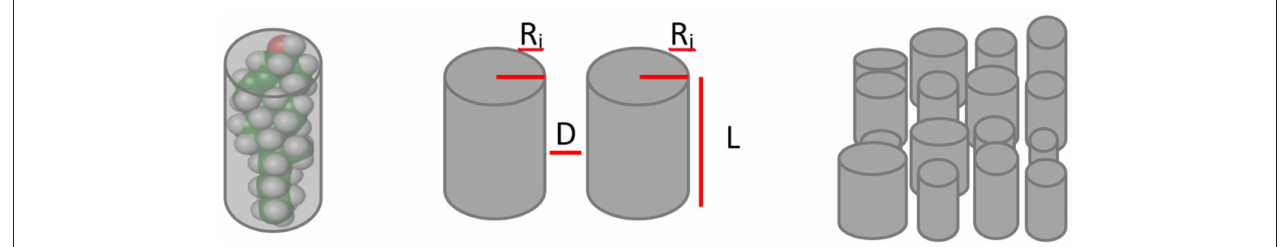
FIGURE 1 | Lipid groups representation. Lipid molecules are simplified as the cylinder that best fits their volume and then are parametrized by their radiuses (R i , R j ), lengths (L) and mean distance between them (D). Finally they are disposed in a matrix to simulate the cell